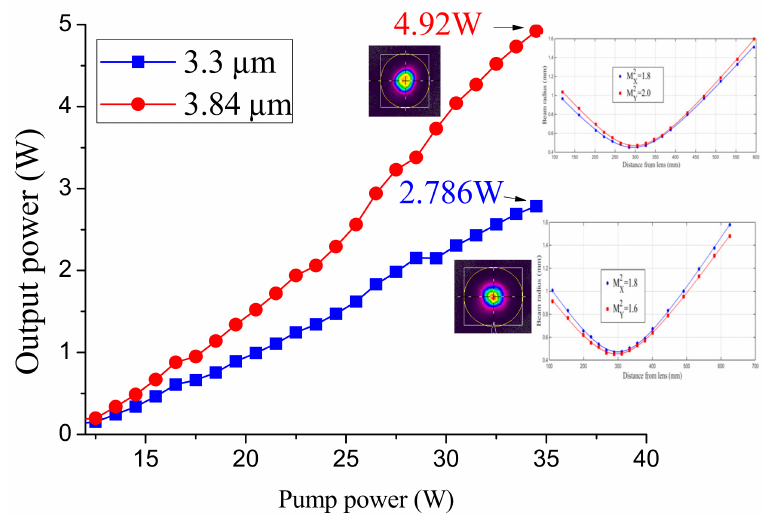
Figure 8. Output power and beam qualities with the transmittance of 60%.